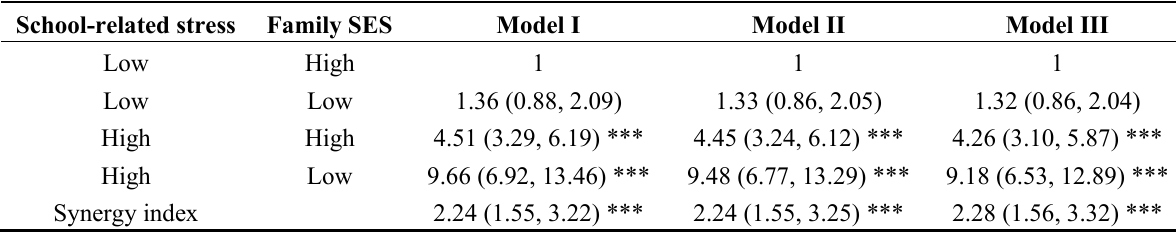
Table 3. Joint effects of school-related stress and family SES on depressive symptoms (ORs and 95%